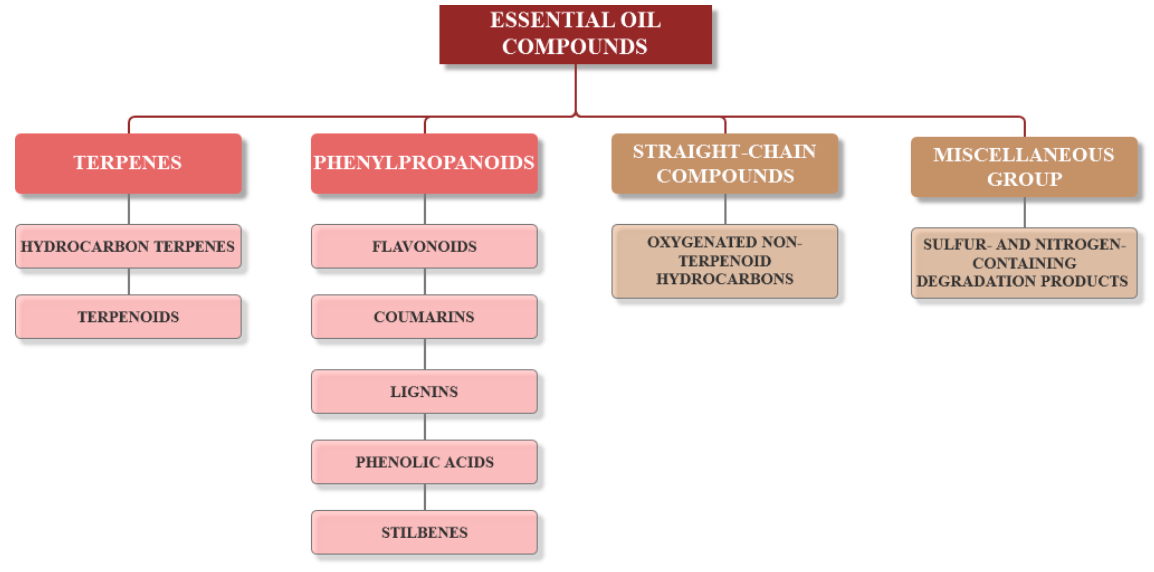
Figure 1. The four major classes of compounds found in essential oils.